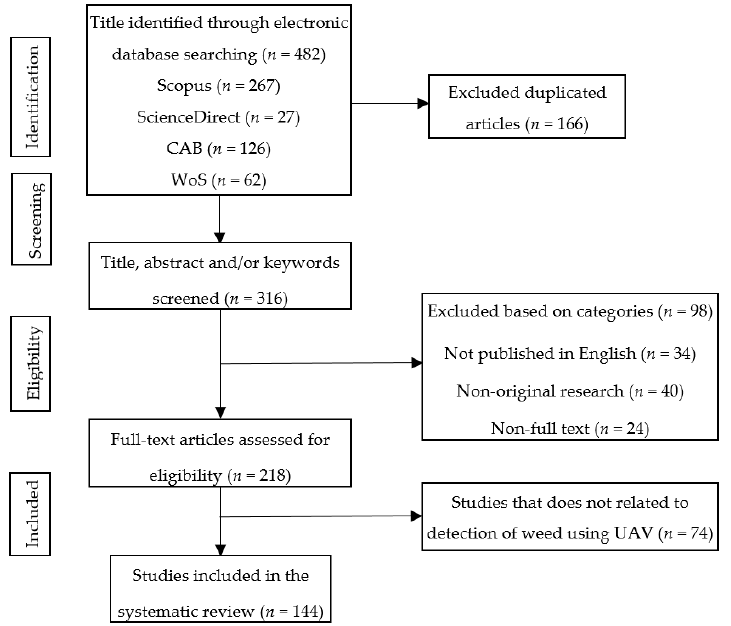
Figure 2. Flow diagram for the study selection. Table 3. The search strategies.